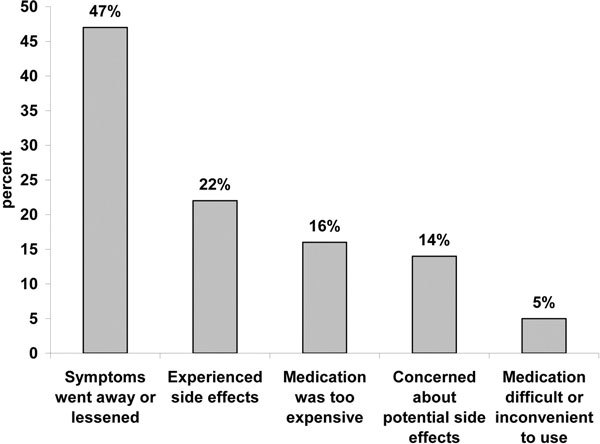
Reasons for patients switching asthma medications. Question: Since being diagnosed with asthma, have you ever switched from one asthma medication to another or discontinued an asthma medication because....?